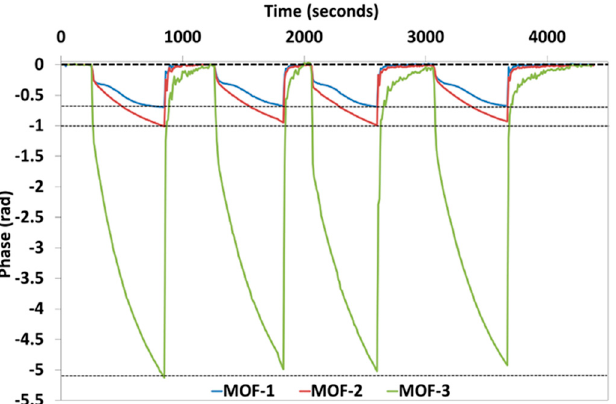
Figure 4. Phase responses of the three sensors for saturated atmospheres of